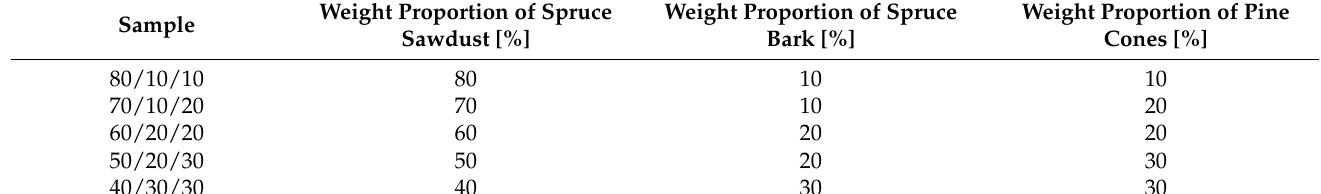
Table 1. Proportions of created pellets.